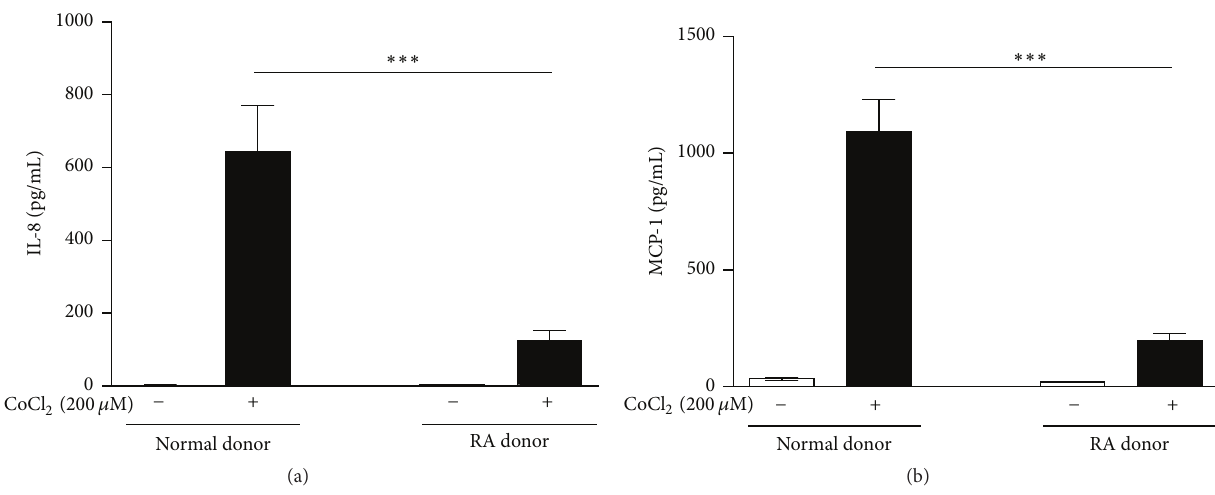
Figure 2: Effect of CoCl 2 stimulation on IL-8 and MCP-1 secretion in normal FLS and RAFLS. Human primary FLS from normal ( 𝑛 = 4 ) and RA ( 𝑛 = 4 ) donors were incubated with 200 𝜇 M CoCl 2 . The amounts of IL-8 (a) and MCP-1 (b) released in the supernatants were monitored 24 h after stimulation. The data are the means ± SE from four experiments (4 different donors) performed in triplicate (3 independent experiments). For statistical comparative analyses, we compared RA to normal FLS treated with CoCl 2 . ∗∗∗ 𝑝 < 0.001